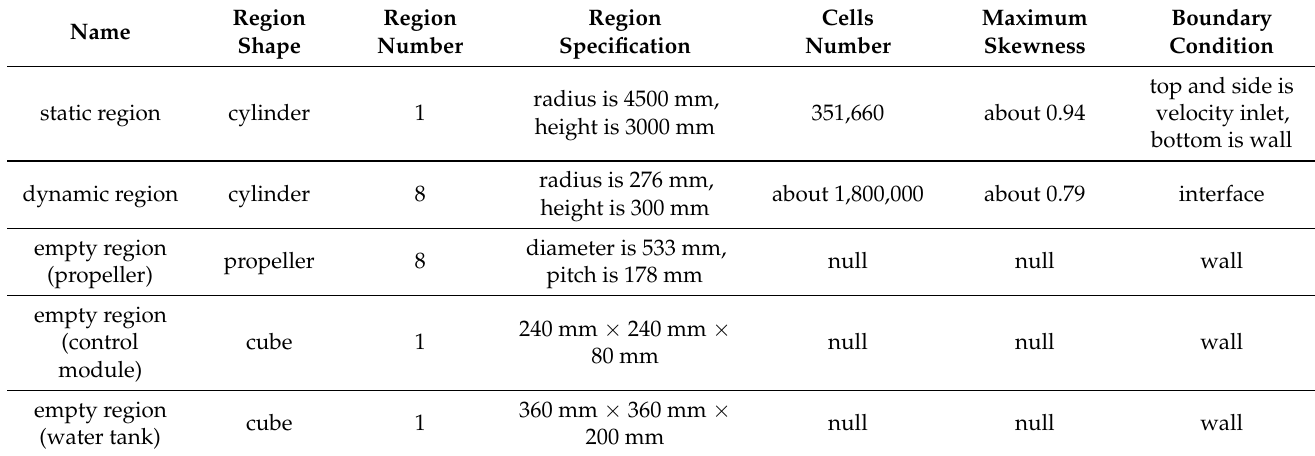
Table 2. Parameter setting of UAV in CFD